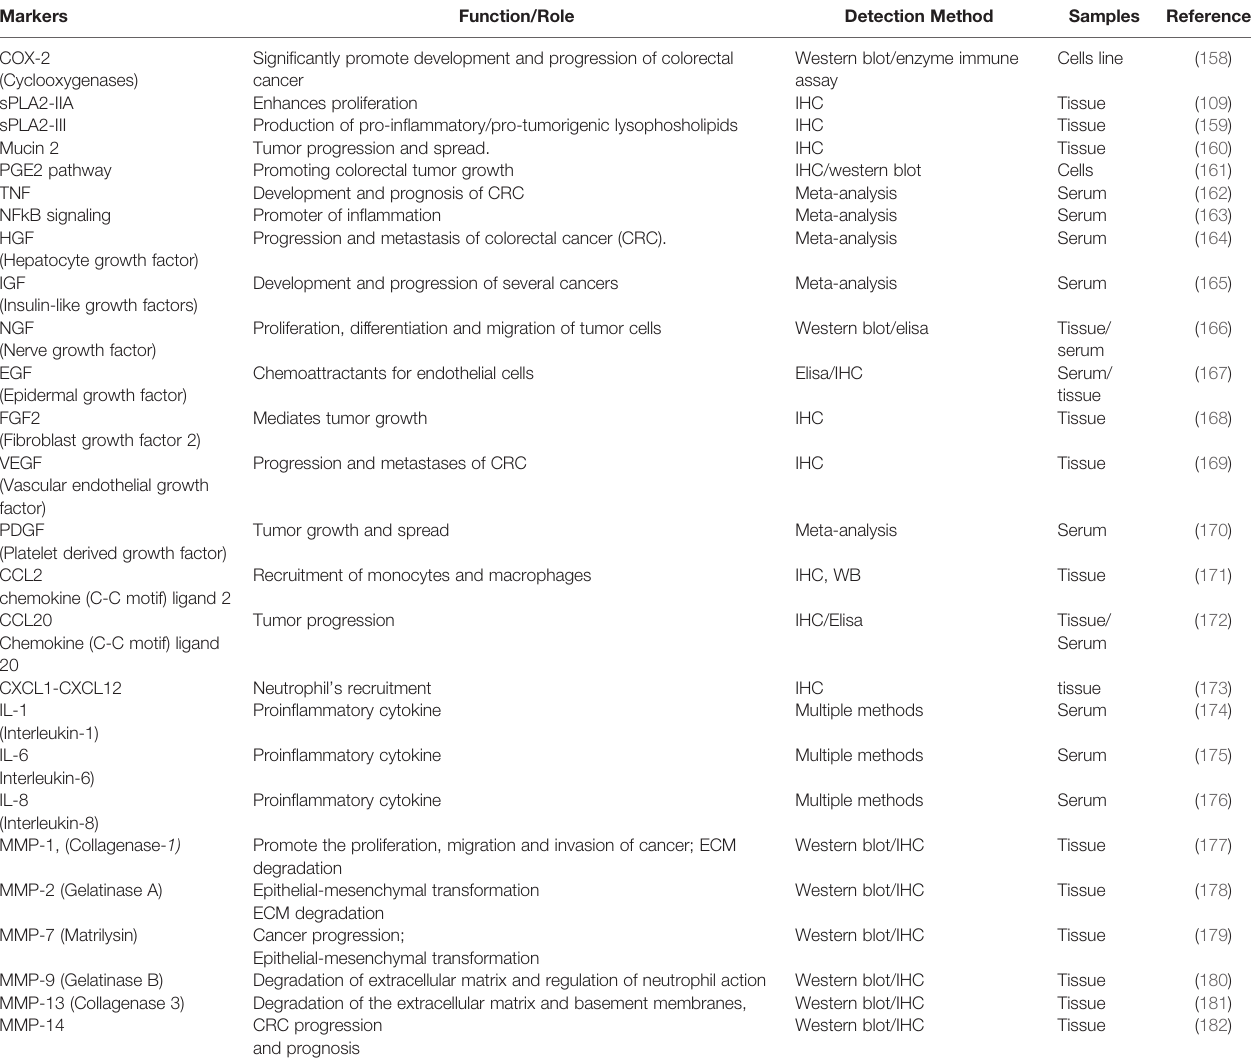
TABLE 3 | Speci fi c in fl ammatory markers that can be used in early-stage colorectal cancer